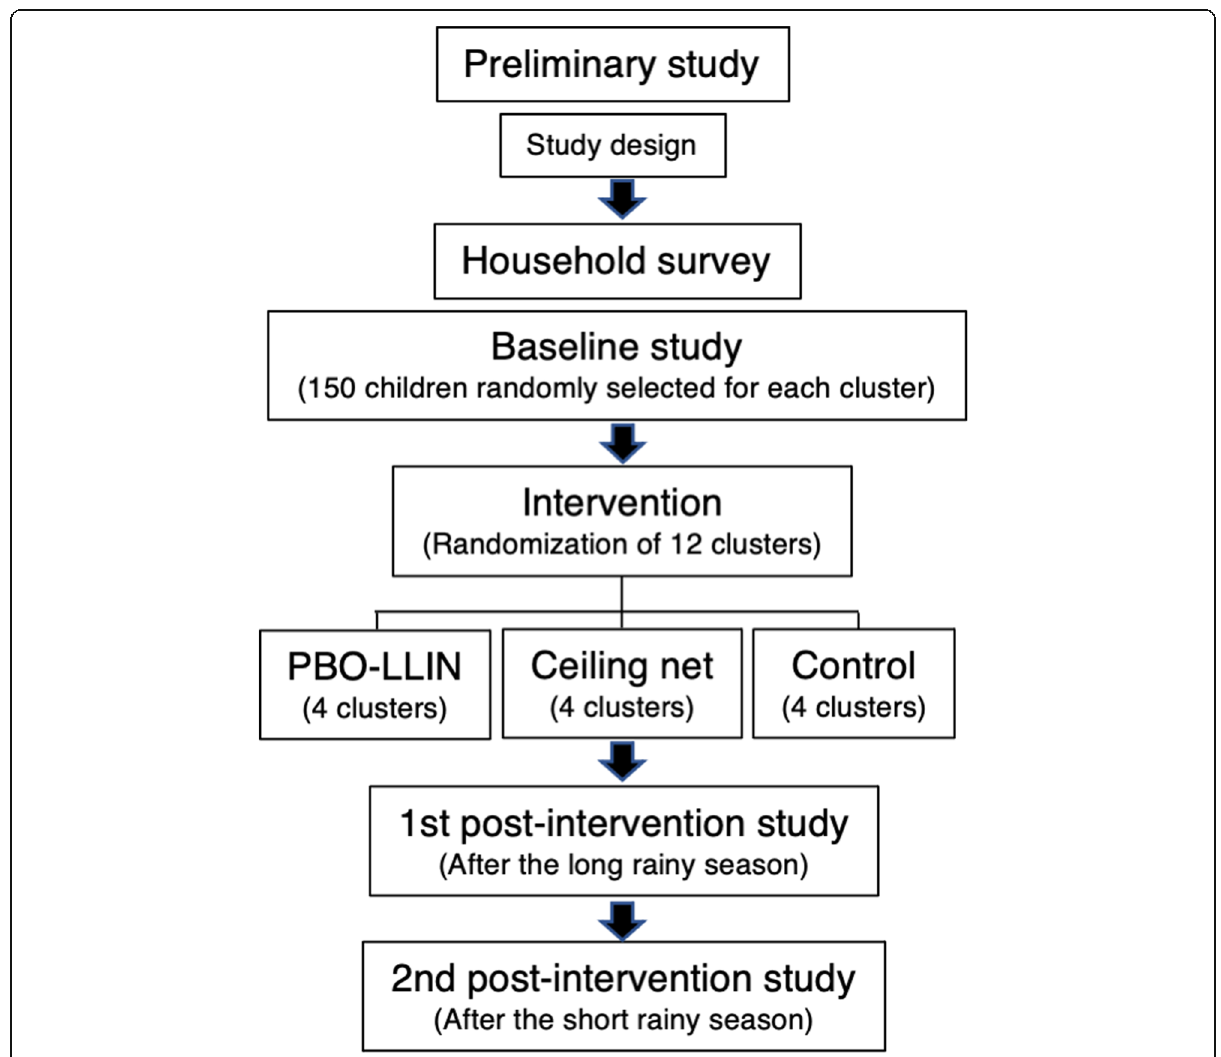
Fig. 6 Flowchart of the study